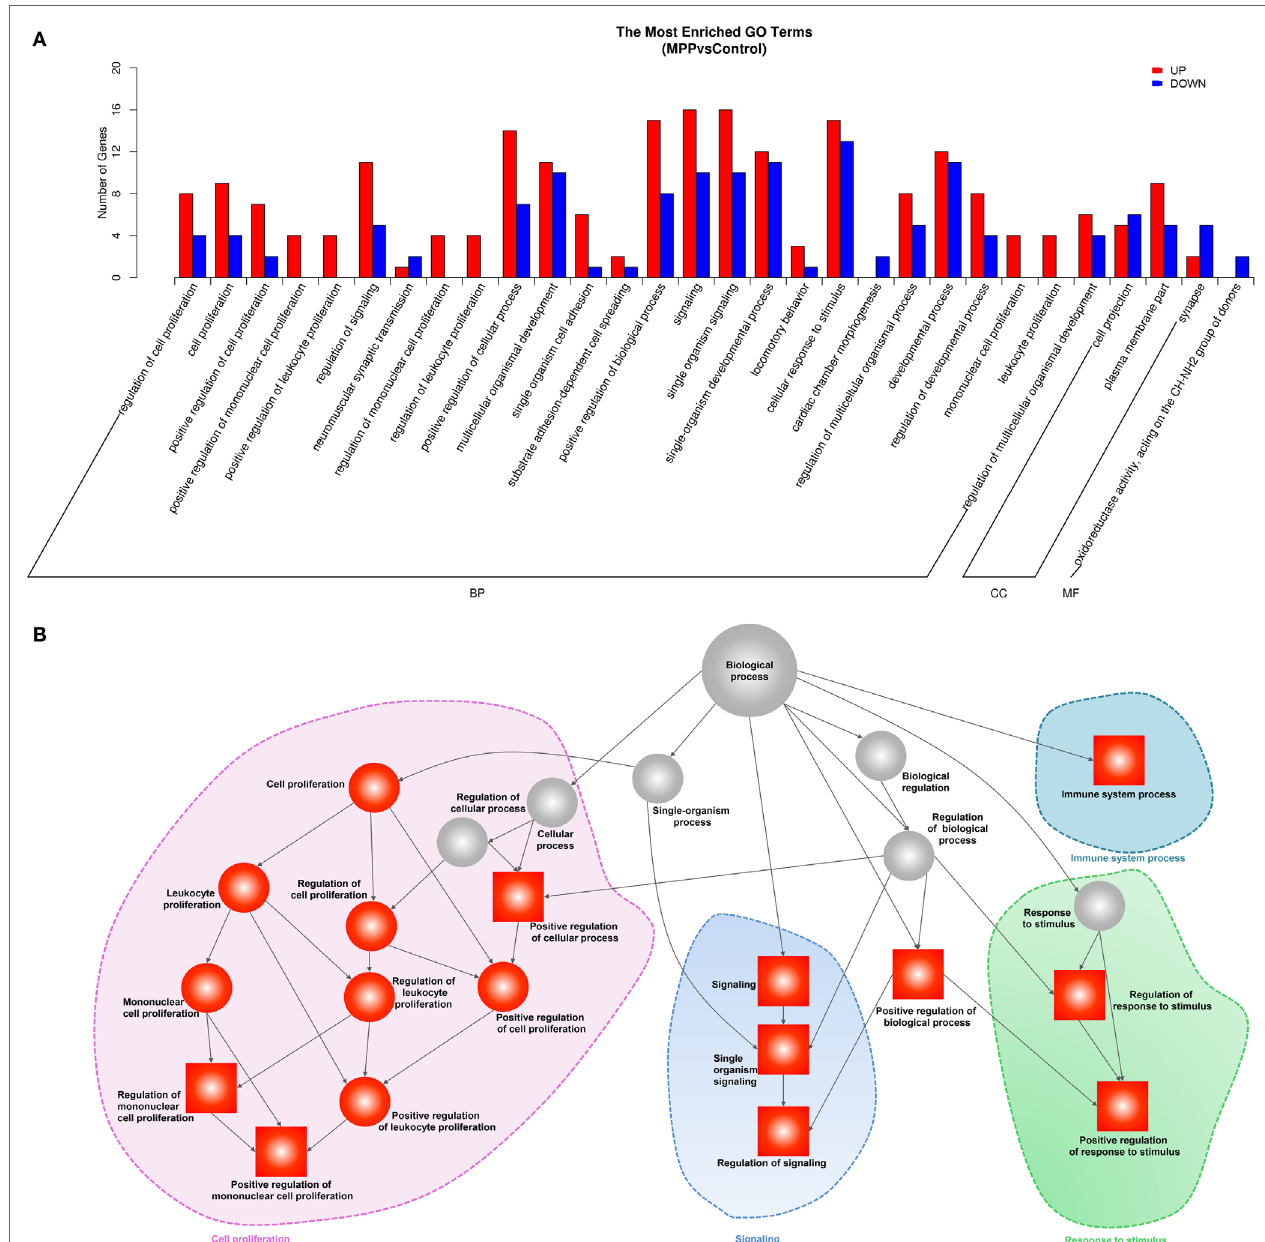
FigUre 3 | Gene ontology (GO) analysis of the deferentially expressed genes between Mycoplasma pneumoniae pneumonia (MPP) group and control group. (a) Top 30 GO terms were enriched as biochemical processes (BP), cellular components (CCs), or molecular function (MF). The numbers of deferentially expressed genes between MPP and control in each category were compared. Red bars represent upregulated genes, and blue bars represent downregulated genes. (B) Directed acyclic graph of GO enrichment of upregulated genes, the square represents the top 10 GO terms based on adjusted p values; red squares or red circles represent higher degrees of